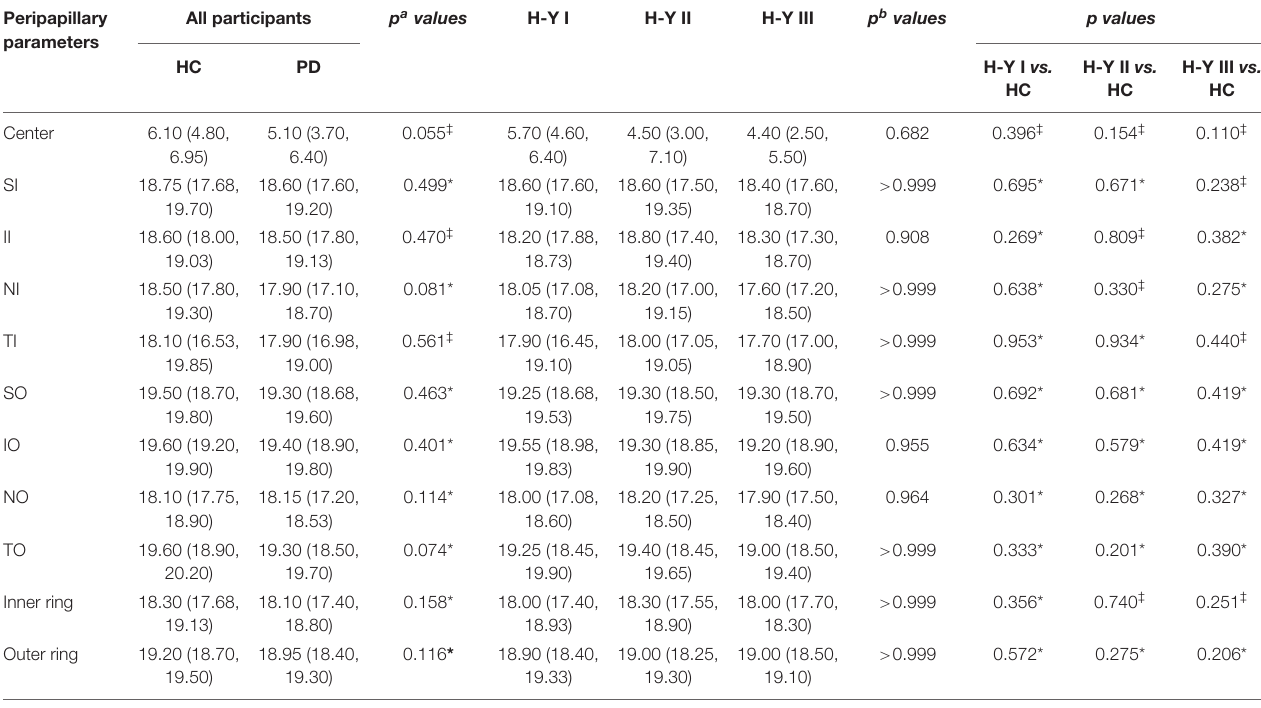
TABLE 3 | Peripapillary vessel density in HC and patients with PD. Peripapillary